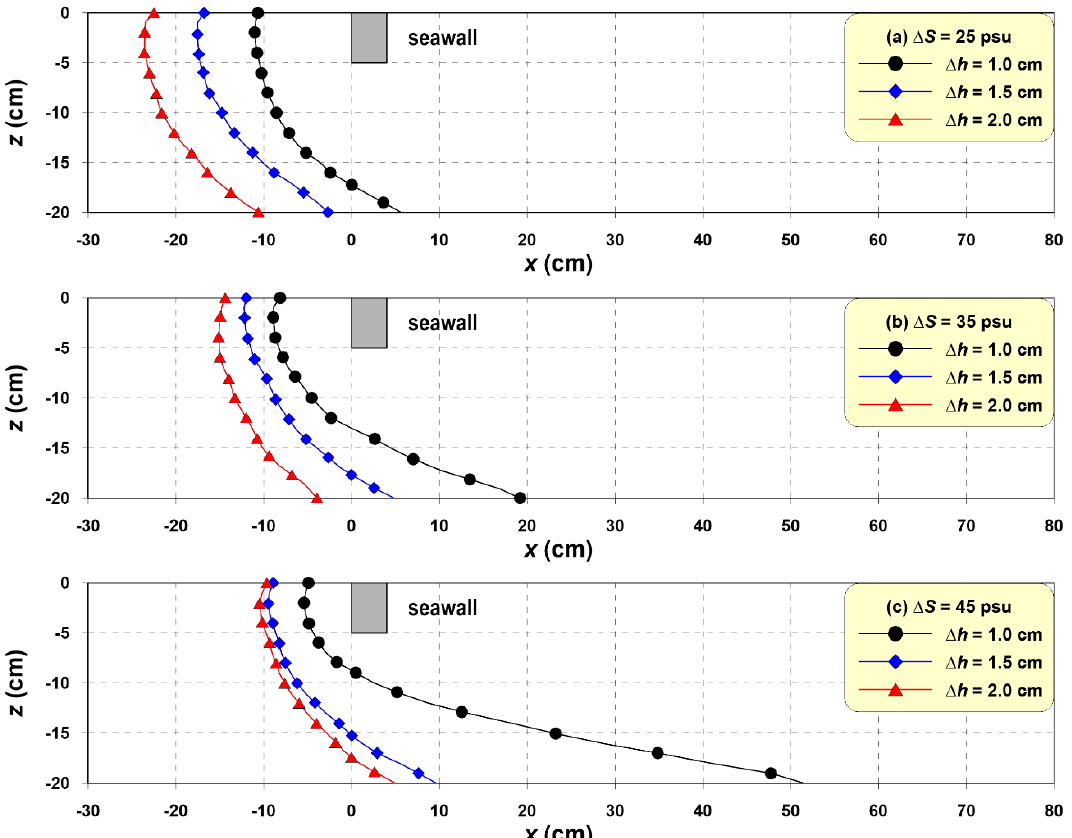
Figure 6. Spatial distributions of saltwater–freshwater interfaces according to ∆ h in a coastal aquifer with a seawall for h = 20 cm with salinity differences of ( a ) 25 psu, ( b ) 35 psu, and ( c ) 45 psu.